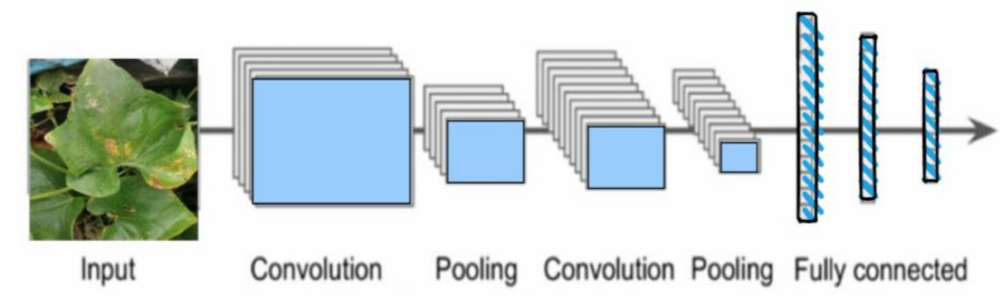
Figure 3. Convolutional neural network architecture.